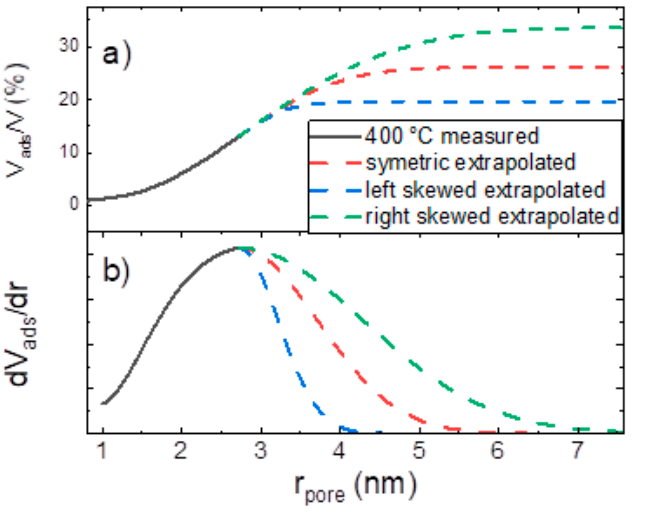
Figure 13. PSD error estimation for the sample calcinated at 400 °C: ( a ) adsorbed volume and ( b ) pore size distribution.